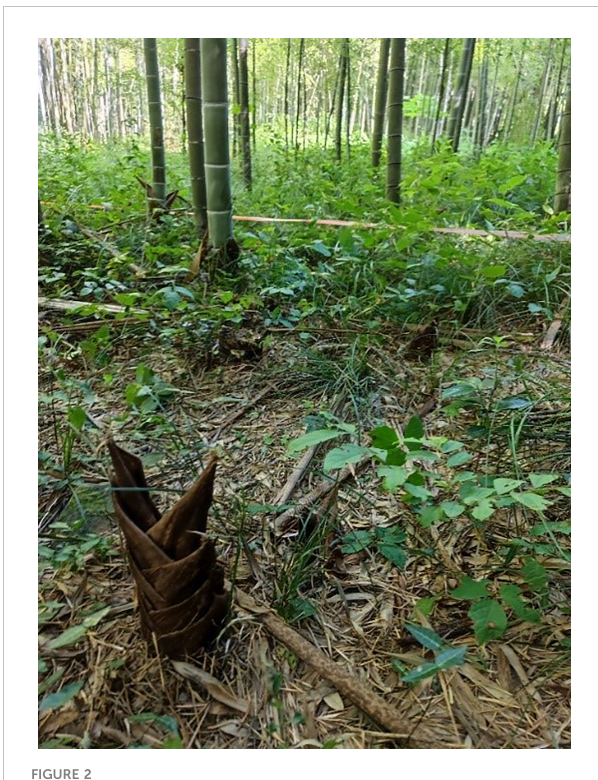
FIGURE 2 Features of moso bamboo in the sample